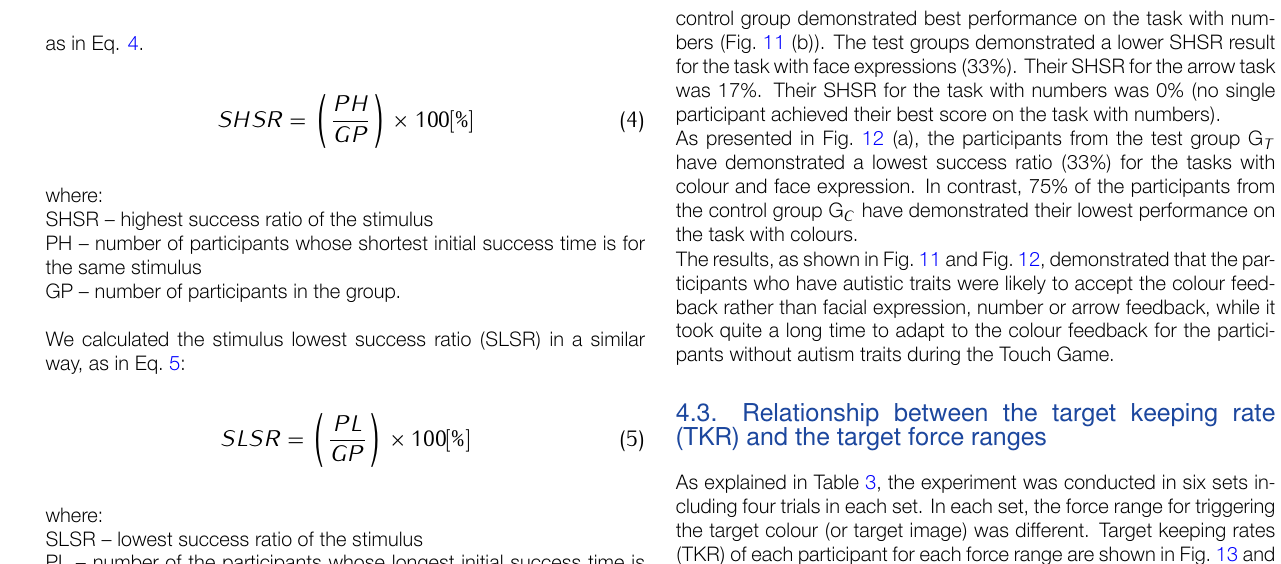
Figure 11. Highest success ratio (SHSR) for each visual stimulus.